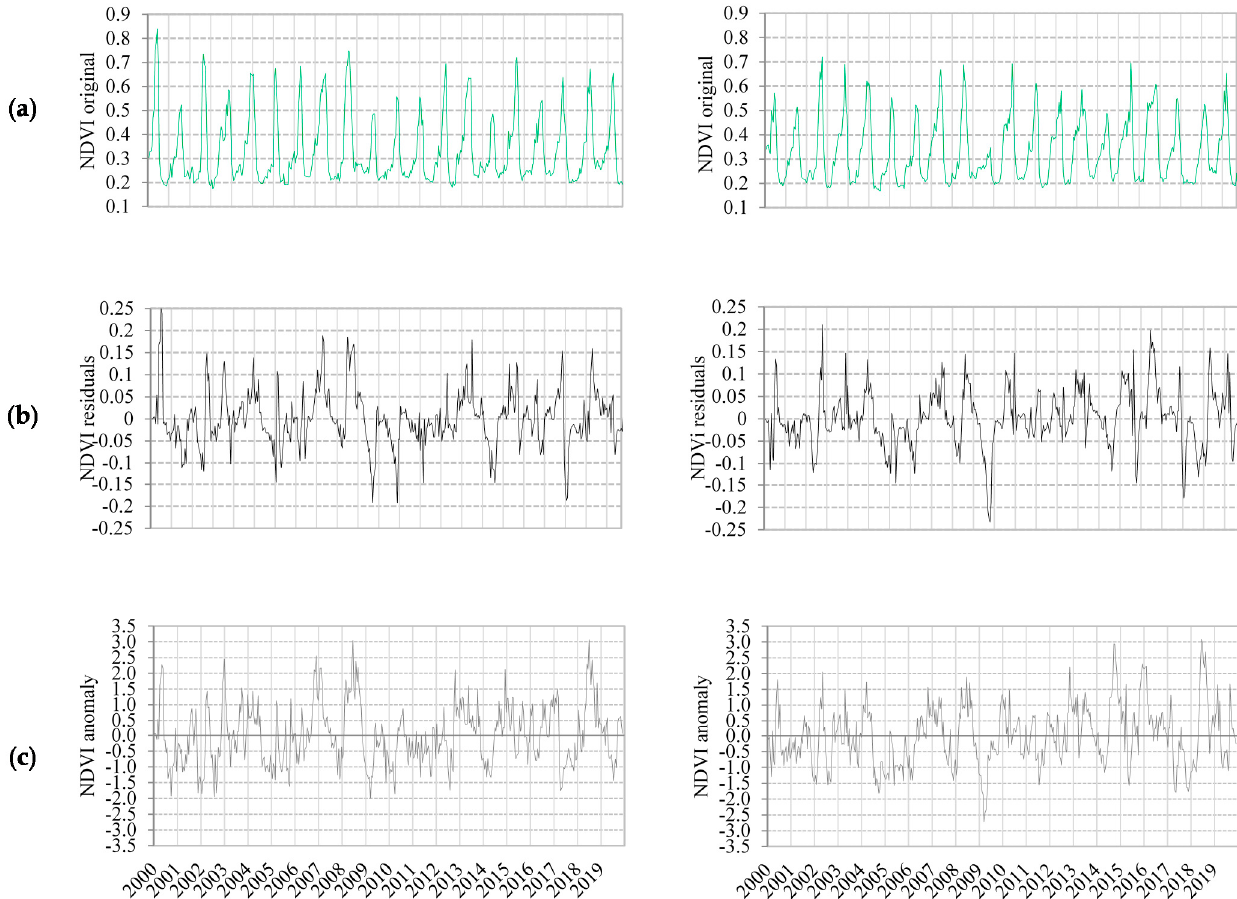
Figure 7. NDVI time series from SOM5 (left column) and SOM15 (right column): ( a ) NDVI original, ( b ) NDVI residual, ( c ) NDVI anomaly. In x -axis is represented the year which includes 23 data points from day of the year (DOY) 1 to DOY 353.